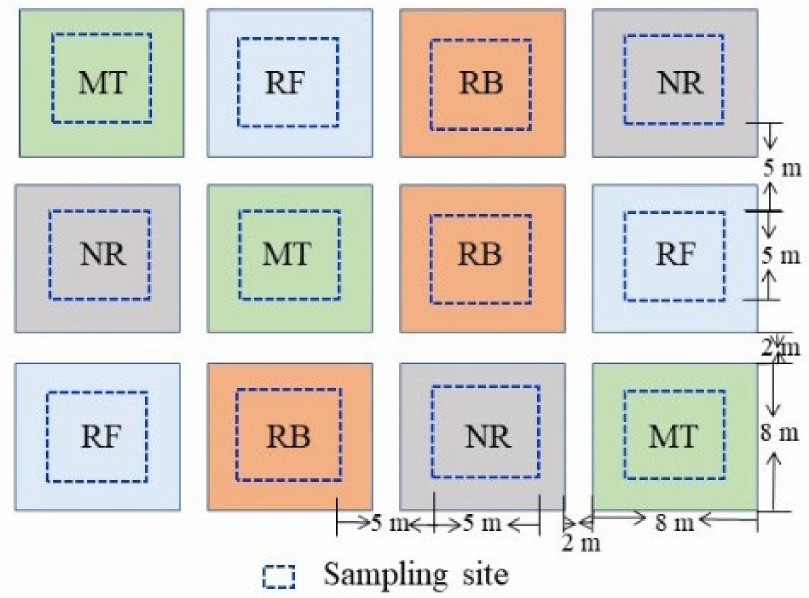
Figure 1. The experimental plot design. Sampling site, 5 m × 5 m in the central area of each plot. RF, reference; RB, residual burning; MT, crushing and mulching treatment; and NR, no